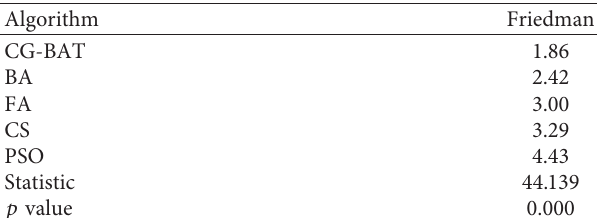
Table 6: Friedman rank test (Experiment